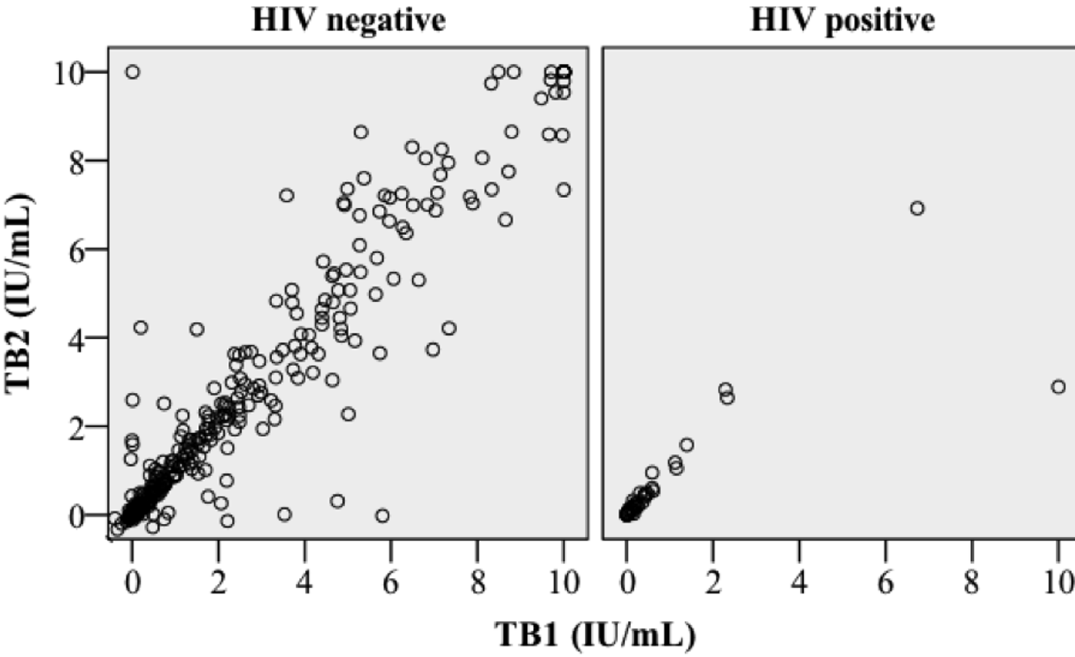
Fig 1. Association of TB1 and TB2 IFN- γ -levels. Scatter-plot of IFN- γ concentrations in TB1 and TB2 divided by HIV serostatus.